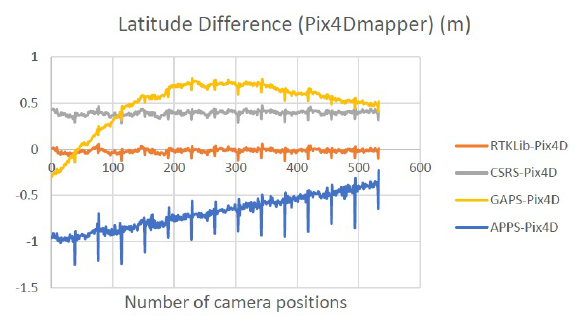
Fig. 12. Latitude differences between the coordinates that were produced by Pix4Dmapper and the software utilized in this